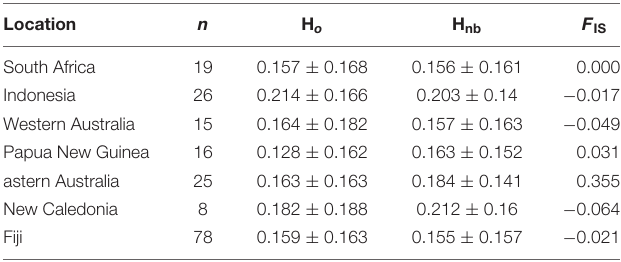
TABLE 2 | Summary of average genetic diversity statistics per population.